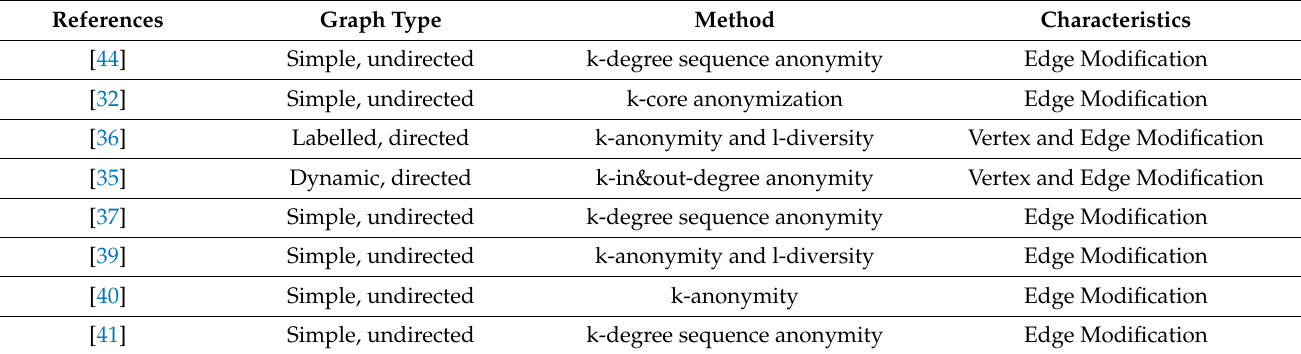
Table 1. The comparison of some recent methods in graph modification